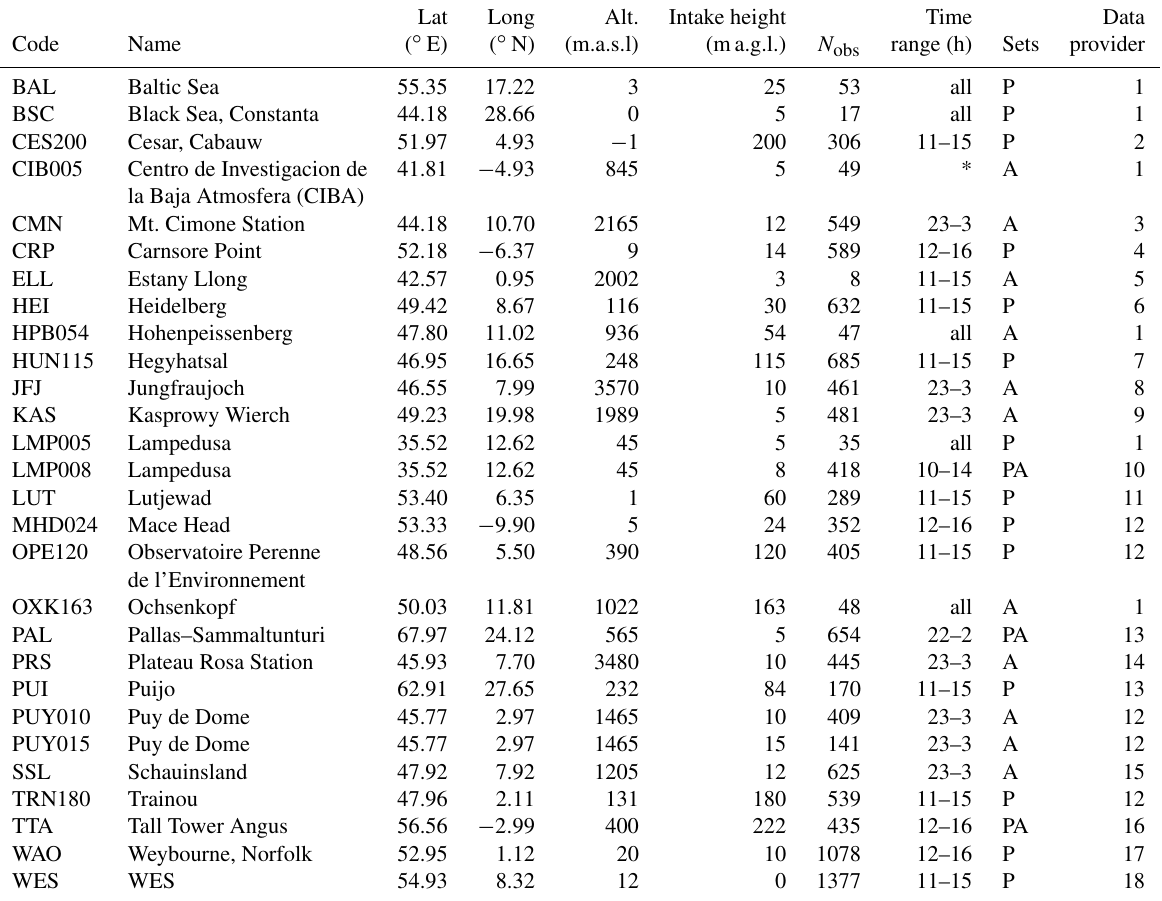
Table 1. Observation sites used in the inversions. The “sets” column refers to the site selection applied in inversions SA/SP and RA/RP; set P includes only low-altitude sites and set A includes mostly high-altitude sites. Data providers are as follows. 1: Cooperative Global Atmospheric Data Integration Project (2017); 2: Vermeulen et al. (2011); 3: Ciattaglia et al. (1987); 4: David Dodd (EPA Ireland); 5: Josep Anton Morguí and Roger Curcoll (ICTA-UAB, Spain); 6: Hammer et al. (2008); 7: Haszpra et al. (2001); 8: Uglietti et al. (2011); 9: Rozanski et al. (2014); 10: Alcide Giorgio di Sarra (ENEA, Italy); 11: van der Laan et al. (2009); 12: Yver et al. (2011); 13: Hatakka et al. (2003); 14: Francesco Apadula (RSE, Italy); 15: Schmidt (2003); 16: Ganesan et al. (2015); 17: Wilson (2012); 18: Karin Uhse (UBA, Germany).